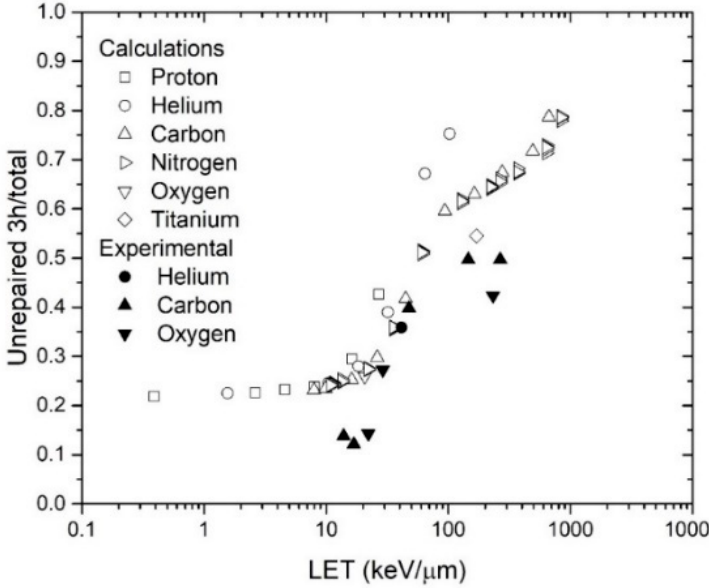
Figure 7. Fraction of remaining breaks 3 hours after irradiation with H, He, C, O, or Ti as a function of the LET, as calculated by RITCARD. Experimental results from reference [10].